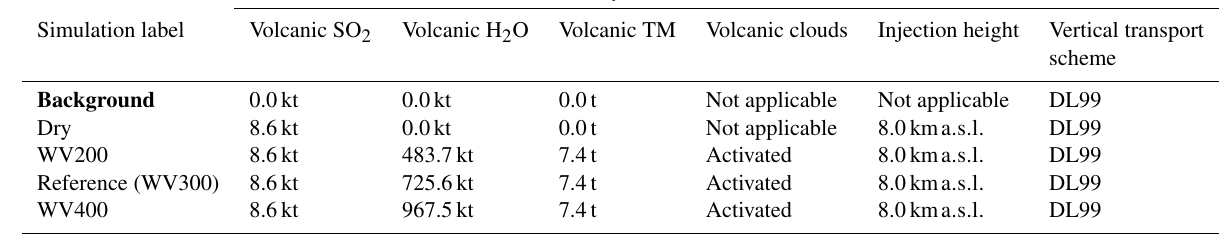
Table 3. Simulation parameters for sensitivity tests on volcanic water emissions. Bold items indicate background simulations that are used to retrieve background values. “Volcanic TM” stands for “volcanic transition metals”. WV200 stands for “water vapour 200” (a mass mixing ratio of 200/1 between water vapour and SO 2 ); similar acronyms are used for WV300 and WV400. The Reference simulation is the closest to a realistic case.